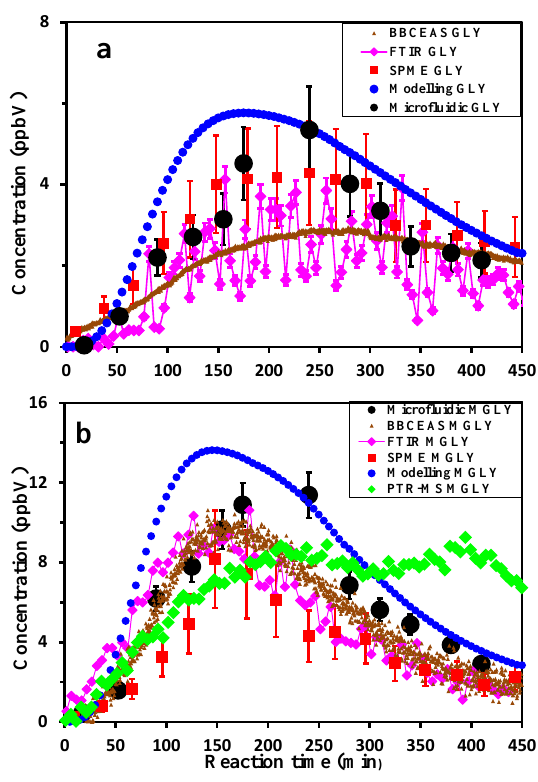
Fig. 5. Comparison of the microfluidic derivatisation technique, FTIR, BBCEAS, PTR-ToF-MS, SPME derivatisation technique and a MCM (v3.2) box model simulation on gaseous GLY and MGLY measurements during isoprene photo-oxidation under low NO con- dition in EUPHORE chamber. (a) : Comparison of GLY measure- ment. (b) : Comparison of MGLY measurement. Error bars show uncertainties of measurements: 6.7% for GLY and 8% for MGLY by microfluidic derivatisation and 30% for both α -dicarbonyls by